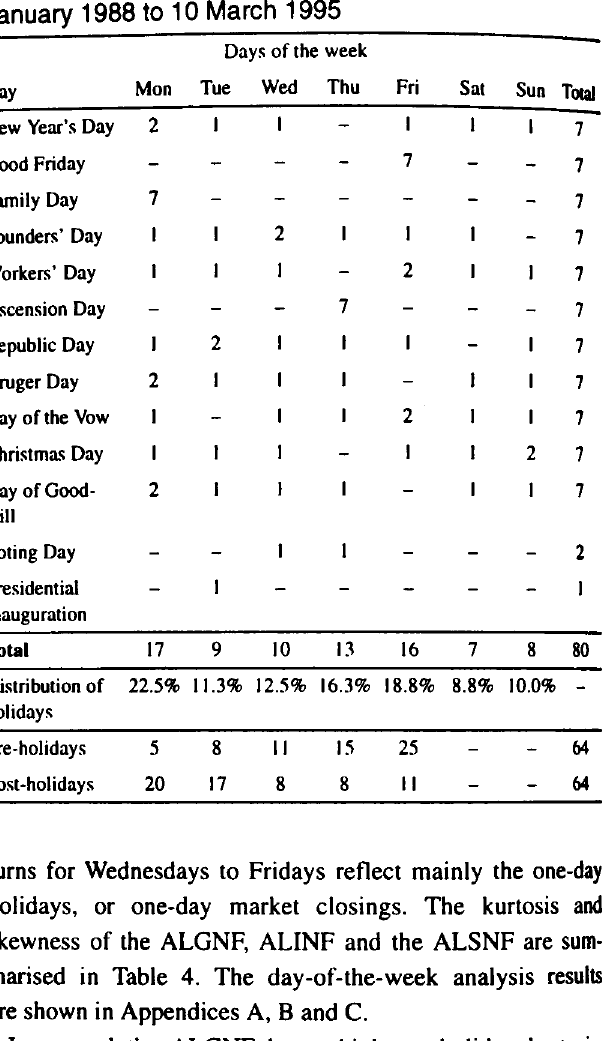
Table 3 South African public holidays for the period 5